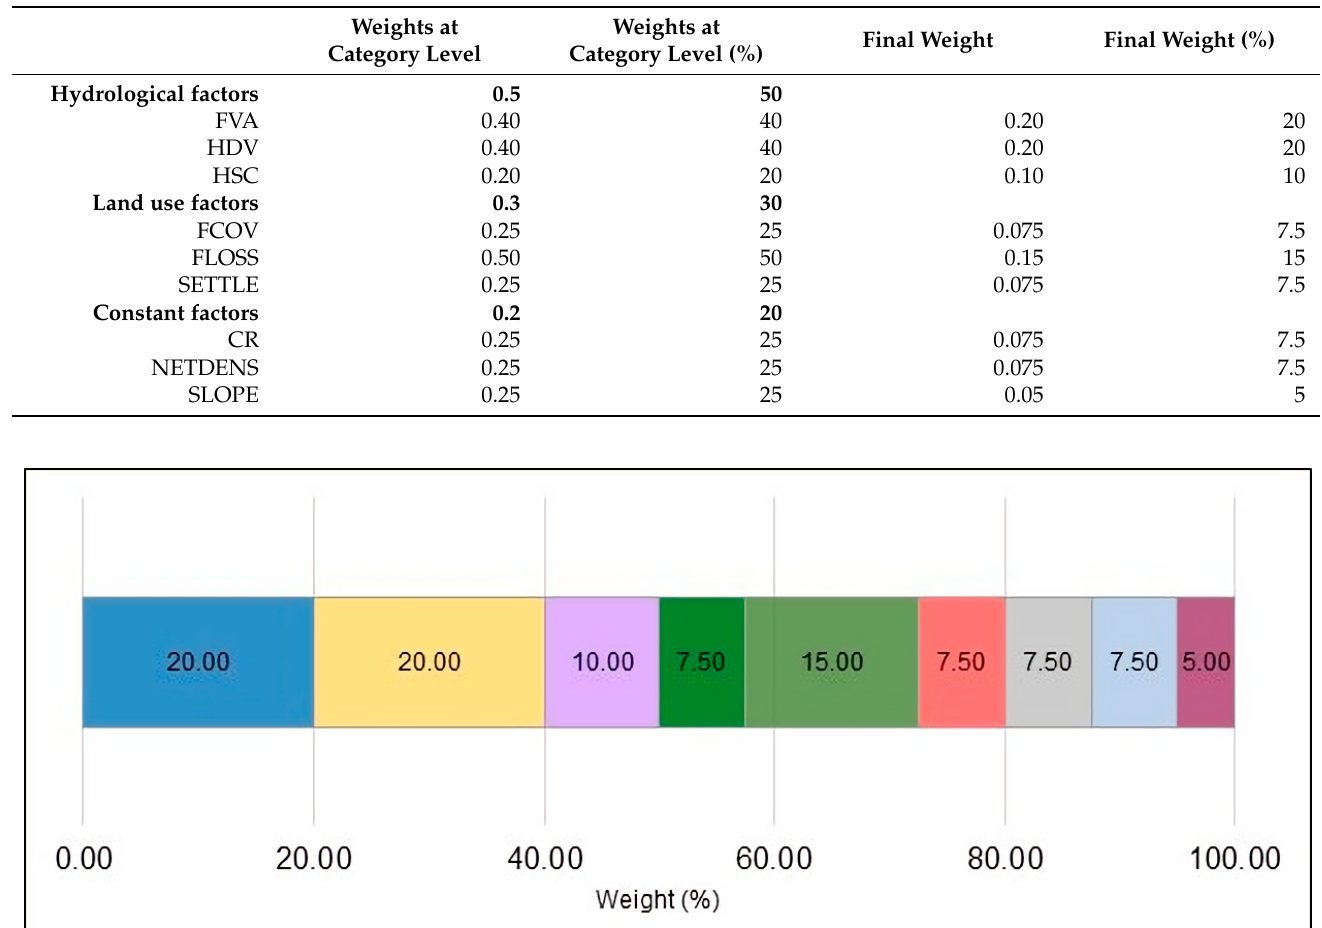
Table 5. The HV classes and their assigned number of drainage basins in 1990–2018.